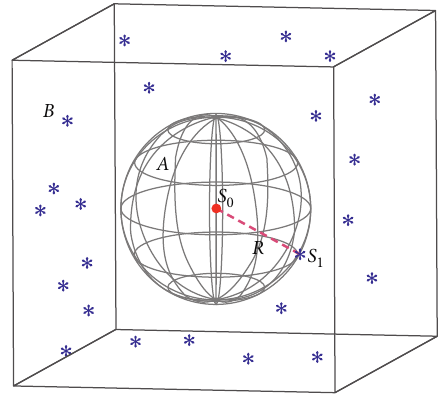
Figure 1: Safety level of the power grid for cascading